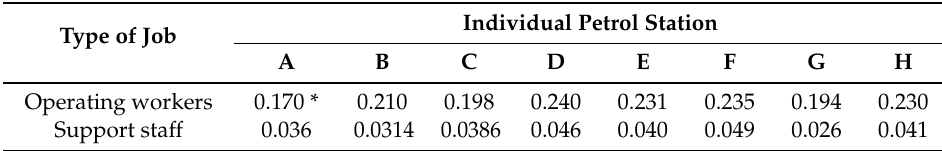
Table 4. Calculated CR per 10 6 at LADD (mg/kg/day) for inhalation exposure to MTBE in petrol stations.